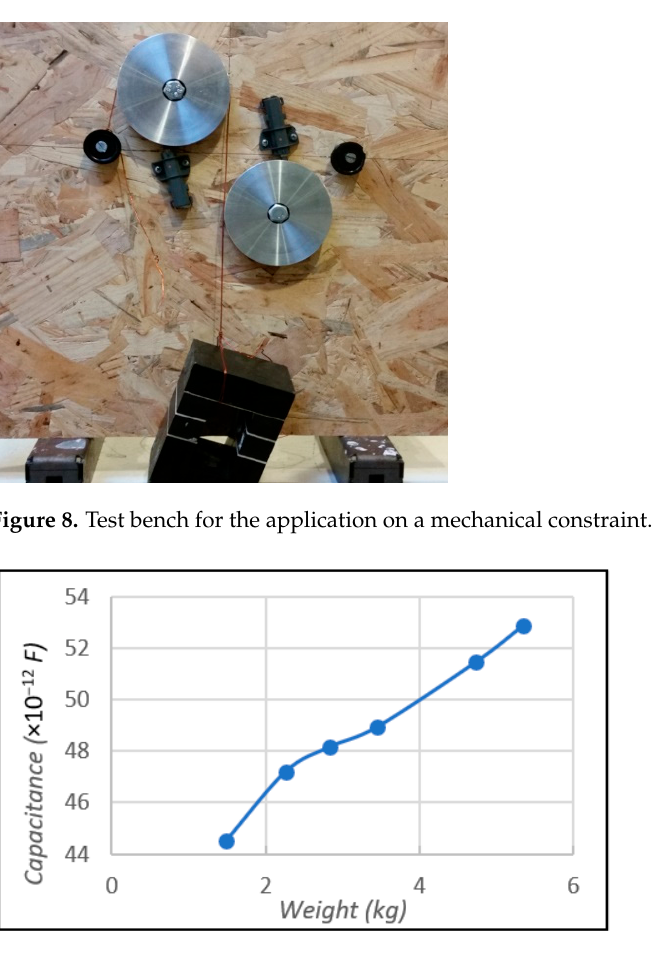
Figure 9. Evolution of the capacitance as a function of the weight applied on the wire.